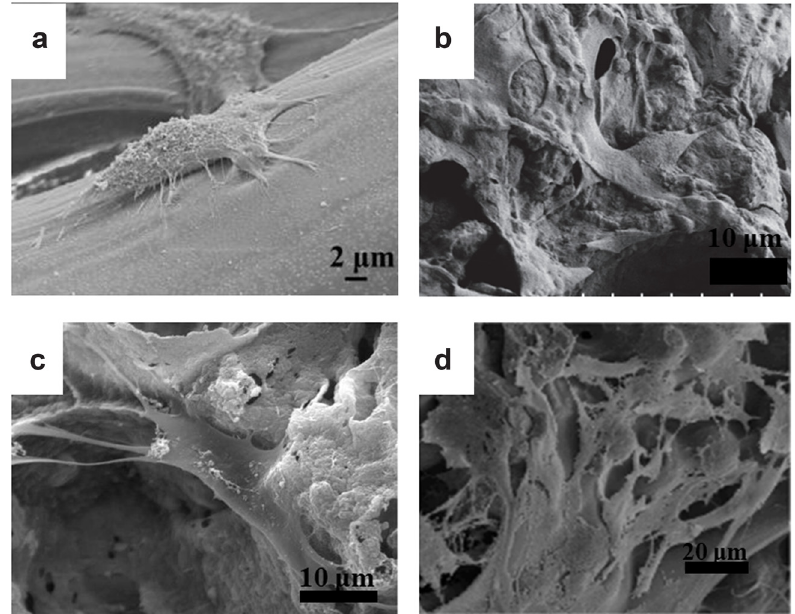
Figure 7: SEM of cell morphology on sca ff olds. ( a ) PLA/nano - HA sca ff olds; ( b ) nano - HA/CM/B9 sca ff olds; ( c ) CS/nano - HA/Zol sca ff olds; ( d ) gel:nano - HA = 1:1 sca ff olds [ 83,88 ]